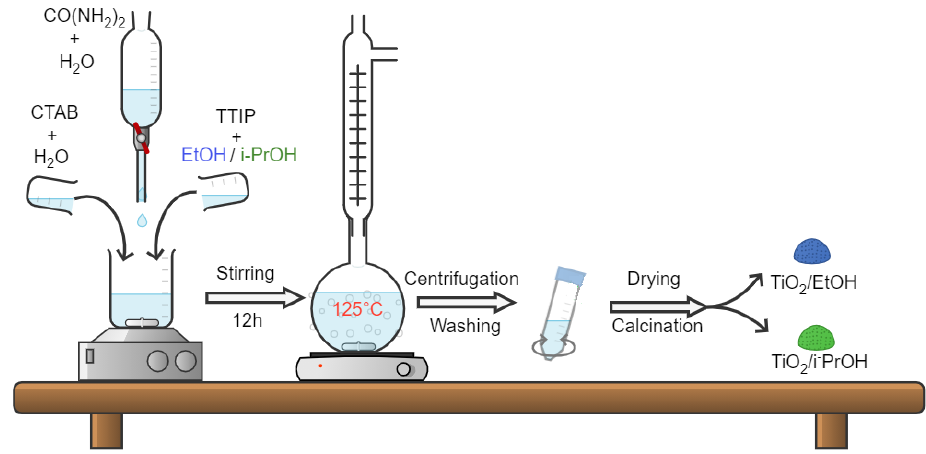
Figure 1. Schematic illustration of procedure used for the preparation of the mesoporous titania